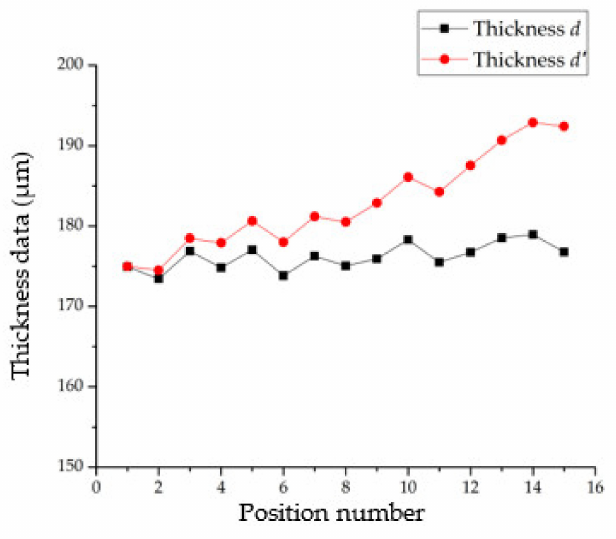
Figure 19. The thickness measurement data of Sample 2.